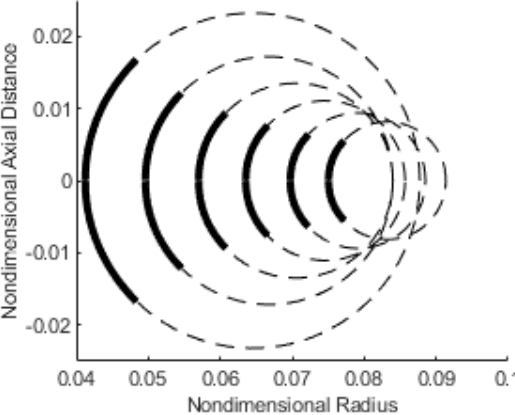
Figure 3. Comparison between the geometry of the bridge profile as given by the numerical solution of the exact Laplace–Young equation (solid lines) and circular arcs representing the toroidal approximation (dashed line). The nondimensionalisation of the geometry is through the division by the cube root of the volume of the bridge.